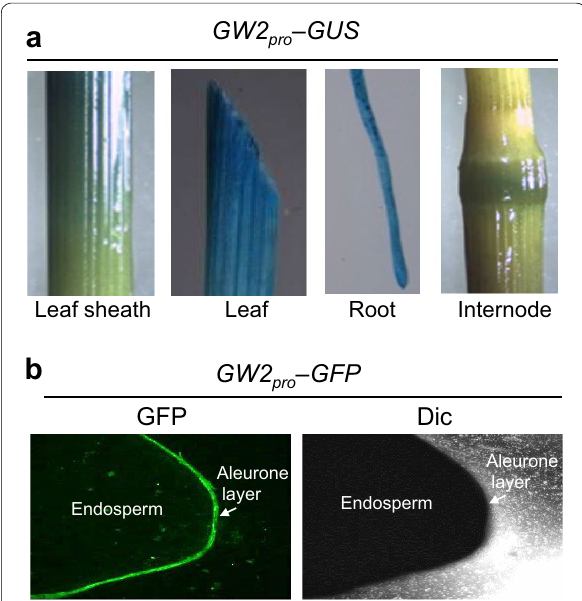
Fig. 5 Expression of GUS and GFP reporter genes under the control of the GW2 promoter. a Examination of GUS expression in GW2 pro - GUS transgenic rice. b Detection of GFP fluorescence in GW2 pro - GFP transgenic rice. GFP imaging was performed using a LAS 4000 imager. GW2 pro GW2 promoter, GUS β-glucuronidase, GFP green fluorescent